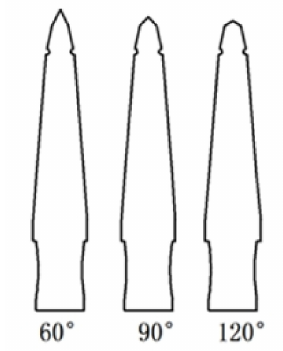
Figure 12. Computational model of three di ff erent cavitation nose angles.